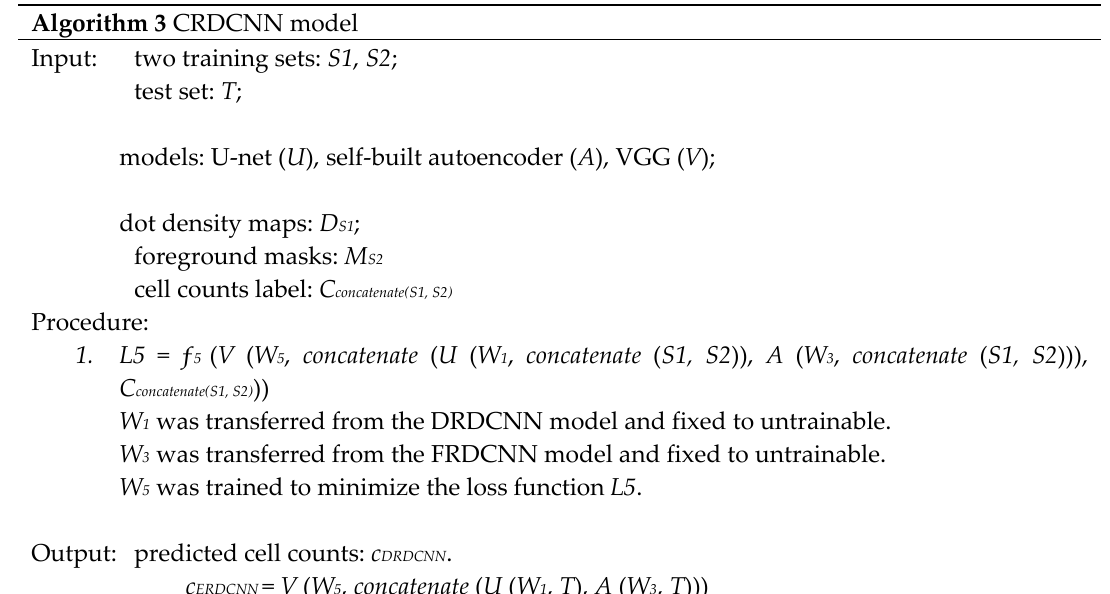
Algorithm 3 CRDCNN